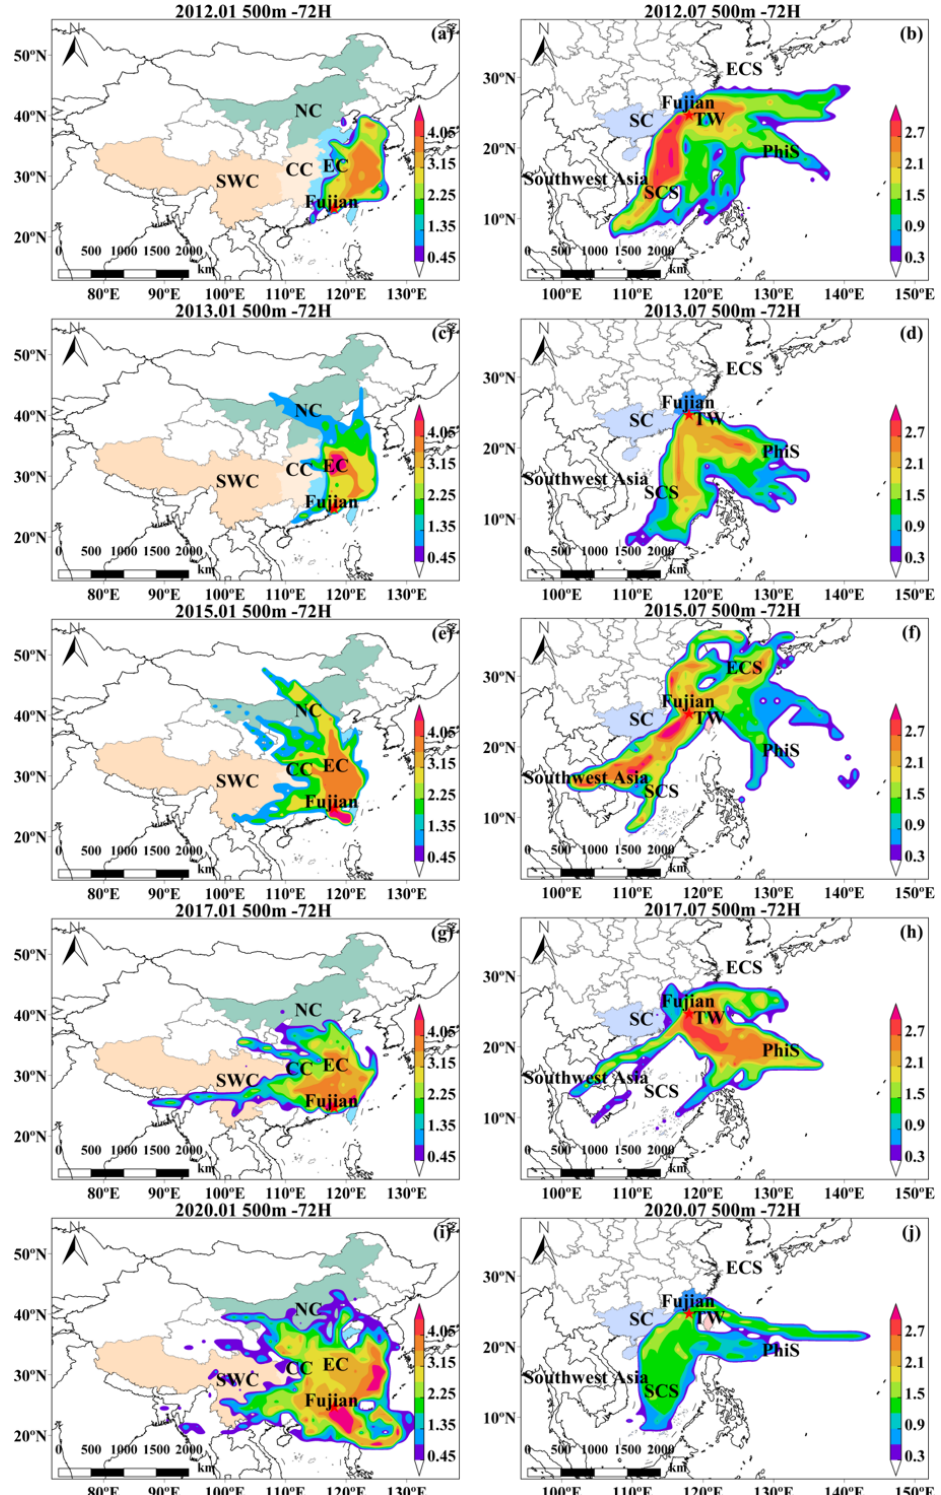
Figure 5. Concentration-weighted trajectory (CWT) in January (a, c, e, g, i) and July (b, d, f, h, j) during the study years. The legend represents the weighted GEM concentrations (ngm − 3